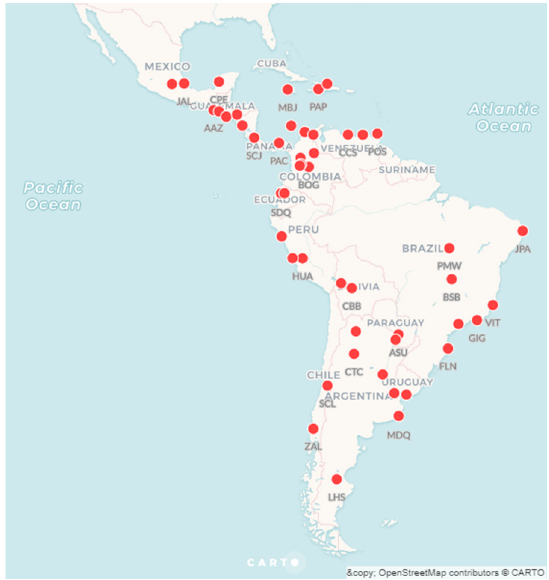
Figure 1. Map of the selected cities for the study.